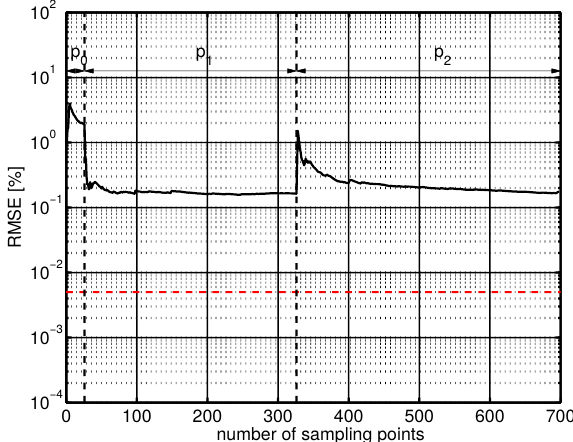
Figure 4. Root mean square error (RMSE) of ζ Blade 1 -prediction of the meta model for takeoff